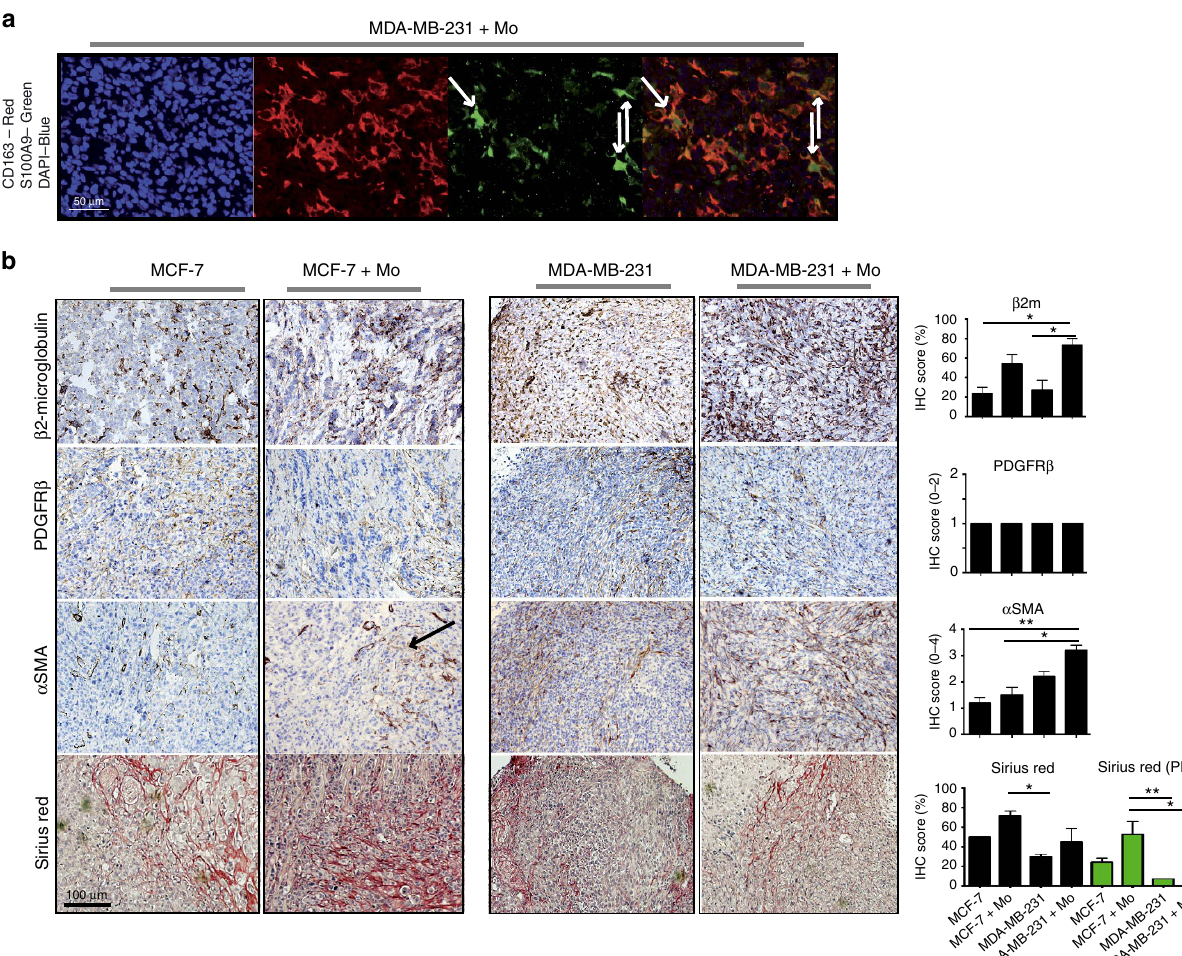
Figure 2 | IHC of xenografts. Tumour xenografts consisting of TN MDA-MB-231 breast cancer cells co-transplanted with primary human monocytes, express more activated stromal markers than luminal A MCF-7/monocyte xenografts. Xenografts were grown in highly immunodeficient NSG-mice (see ‘Methods’ section). ( a ) Immunofluorescence staining of CD163 (TRITC, red) and S100A9 (FITC, green) in sections from MDA-MB-231/monocytes xenograft tumours (day 21). DAPI (blue) shows nuclear staining. Overlay of colours is shown in lower right panel. S100A9 expression is located in the CD163 þ human myeloid co-transplanted cells. White arrows indicate three cells with co-expression of CD163 þ and S100A9. The cell lines are negative